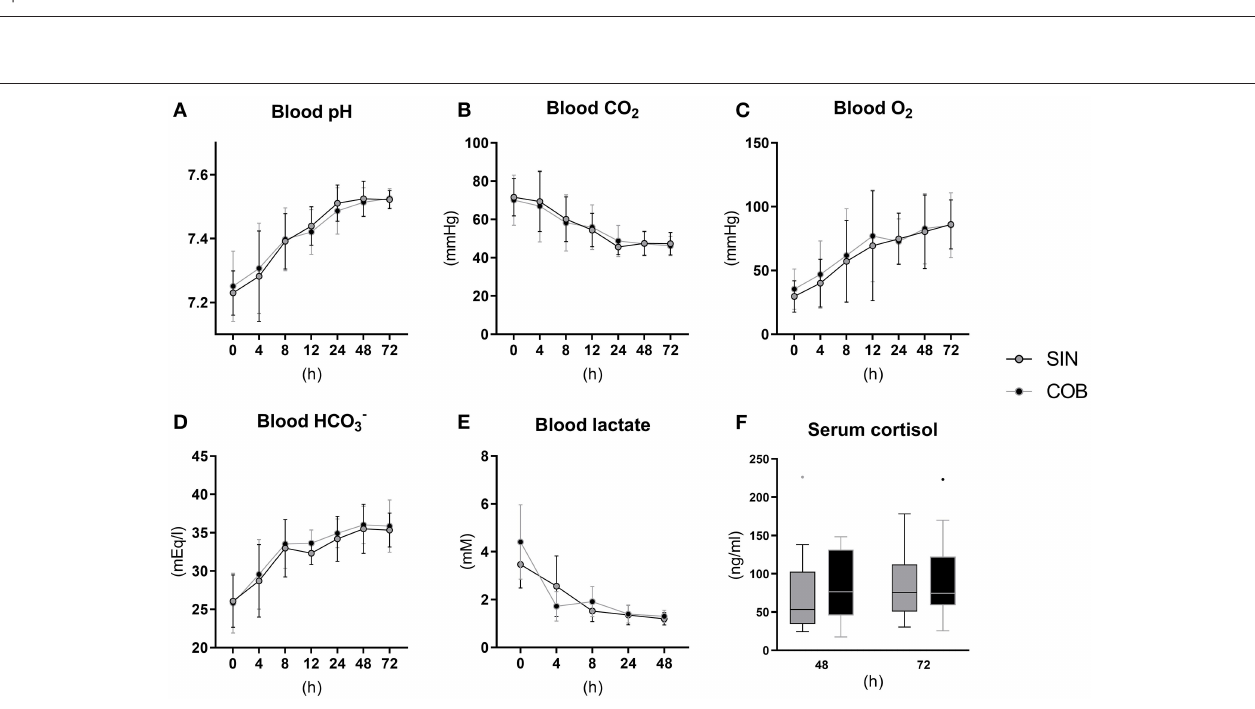
FIGURE 2 | Core body temperature (A) and pulmonary and cardiovascular functions (B–E) in single-housed (SIN) and co-bedded (COB) Preterm piglets. Data is presented as means with standard deviations.